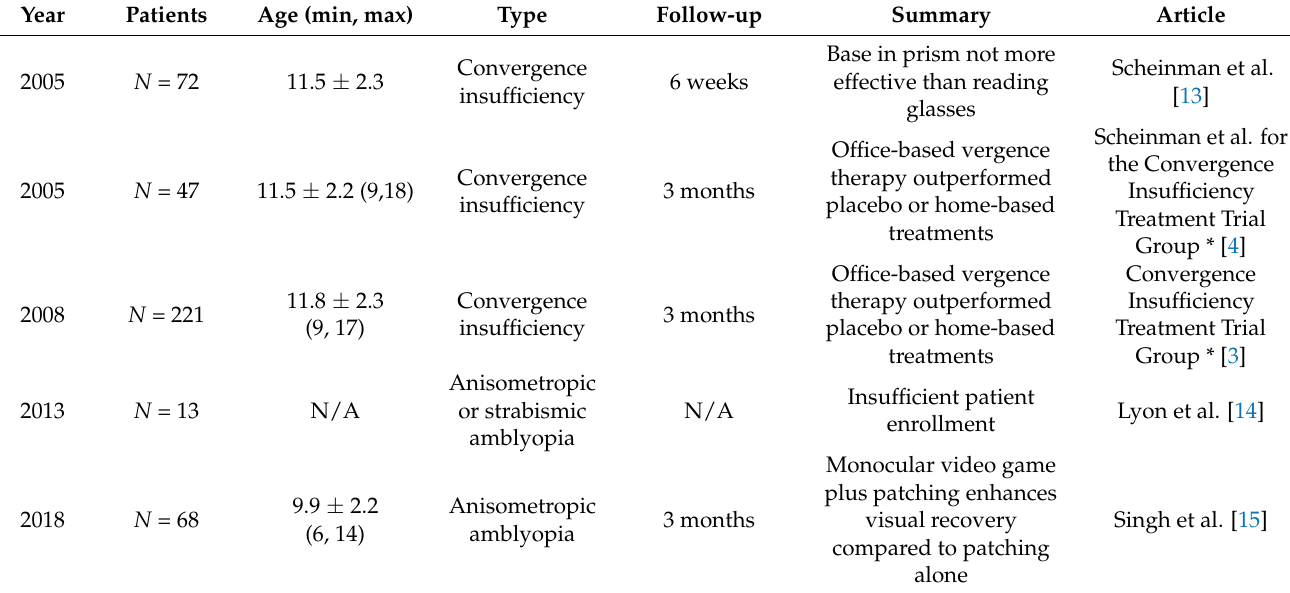
Table 1. Summary of all randomized control trials evaluating the effectiveness of vision therapy in children. * The study published in 2005 is a subset of the study from